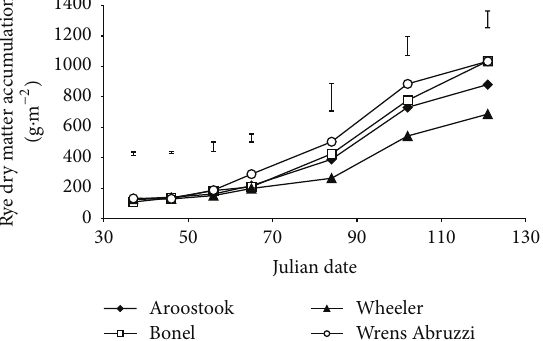
Figure 10: Accumulation of above ground dry matter in four rye varietiesovertime(Juliandates)duringthefirstyearofexperiments. Vertical bars represent standard errors at each sampling date.